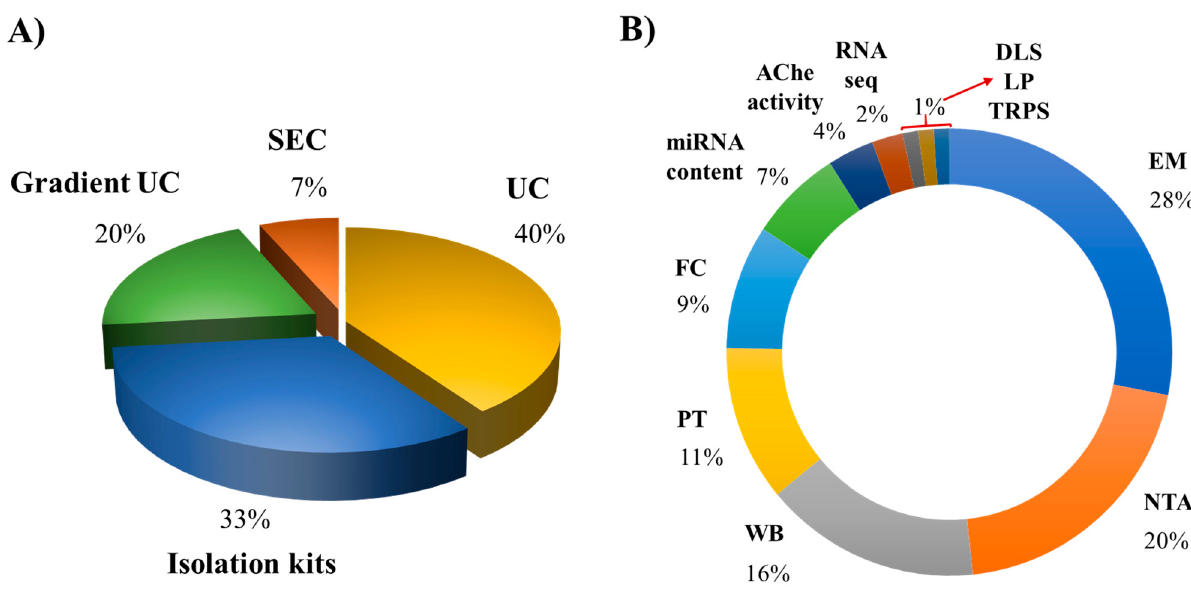
Figure 2. Pie chart of common technologies used for the separation and description of EVs released by human macrophages. ( A ) isolation and ( B ) characterization methods. Abbreviations: UC, ultracentrifugation; SEC, size-exclusion chromatography; EM, electron microscopy; NTA, nanoparticle tracking analysis; WB, western blotting; PT, proteomic analysis; FC, flow cytometer; AChe, acetylcholinesterase activity; DLS, dynamic light scattering; LP, lipidomic analysis; TRPS, tunable resistive pulse sensing.